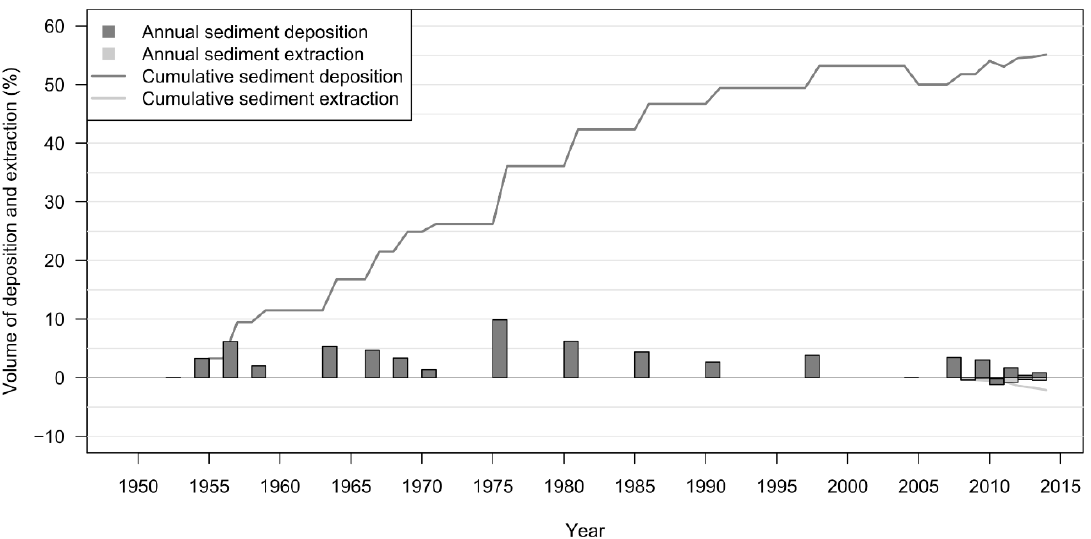
Figure 2. Reservoir sedimentation and removal over time. Note, the sediment extraction began in the 2010s.